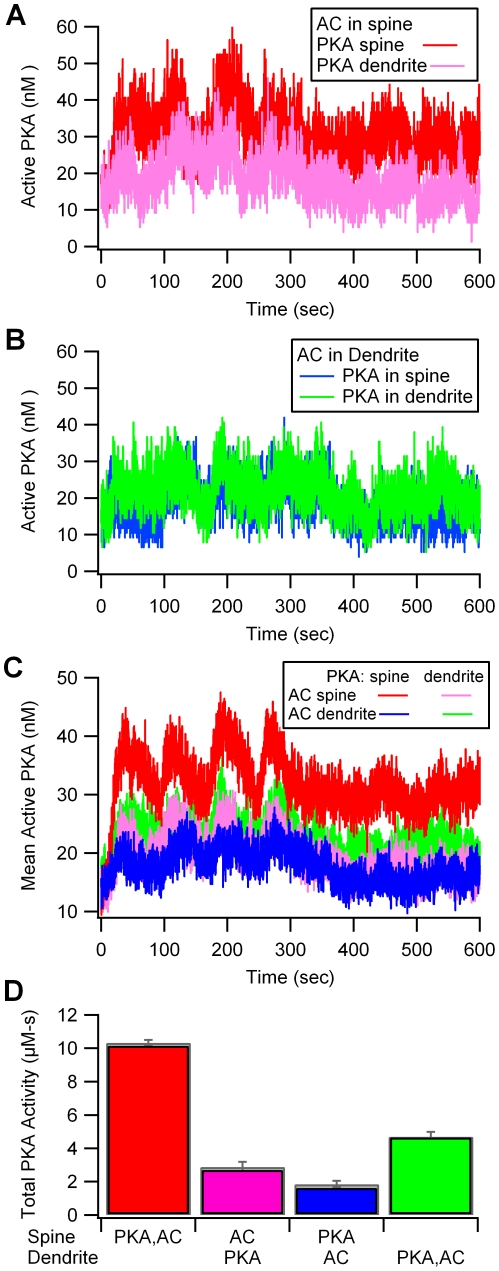
PKA activity is higher when PKA is colocalized with adenylyl cyclase (AC).(A) With AC in the spine, PKA activity is greater when PKA is anchored in the spine (red trace), than when PKA is anchored in the dendrite (pink trace). (B) With AC located in the dendrite (green and blue traces), the effect of PKA anchoring is not apparent. (C) Effect of colocalization is more apparent when averaging over five trials. The quantity of free PKA catalytic subunit is greater when PKA is colocalized with AC in the dendrite (green trace) than when PKA is separated from the AC (blue and pink traces). (D) Total PKA activity (calculated as area under the curve describing concentration of the free catalytic subunit of PKA), reveals that colocalization of AC and PKA produces significantly greater PKA activity than when AC and PKA are anchored apart.